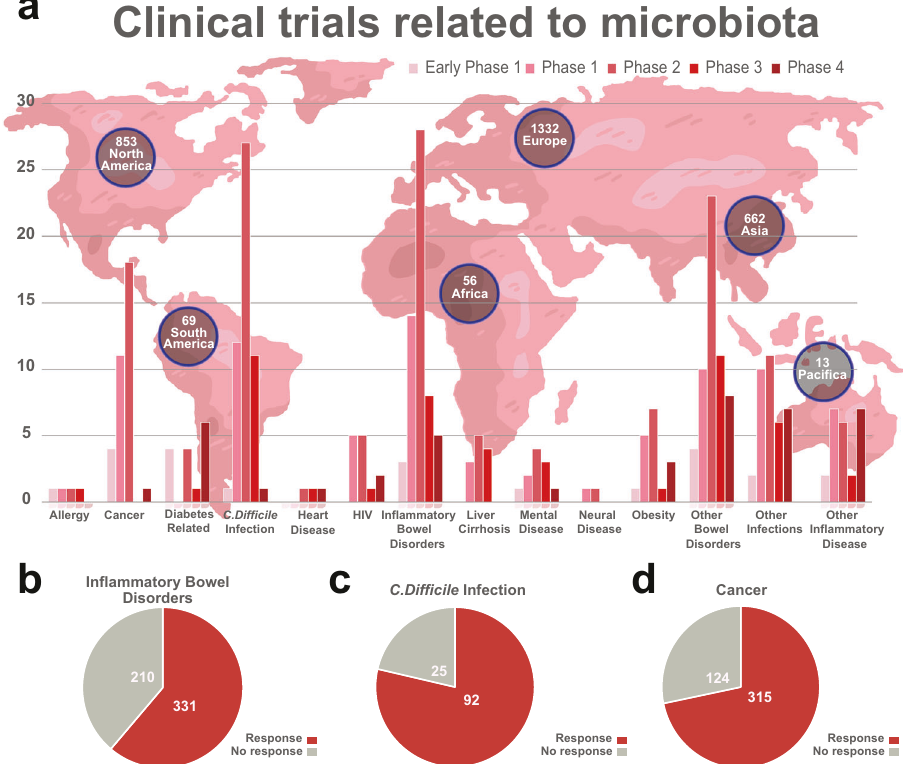
Fig. 5 Current number of microbiota-related clinical trials by regions and study phases. Data are updated until October